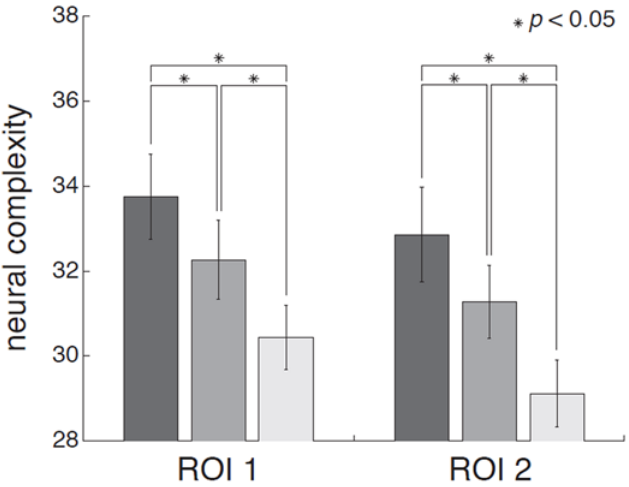
Fig 8. Group results for Neural Complexity analyses. Neural Complexity results for the movie, scrambled movie, and ‘ TV noise ’ conditions. Colors of bars represent conditions (dark gray: movie, medium gray: scrambled movie, light gray: TV noise). Left panel: group means and standard deviation of the mean for Neural Complexity calculated on ROI set 1. Right panel: group means and standard deviation of the mean for Neural Complexity calculated on ROI set 2. Asterisks indicate significant differences of the group means (p < 0.05, corrected).